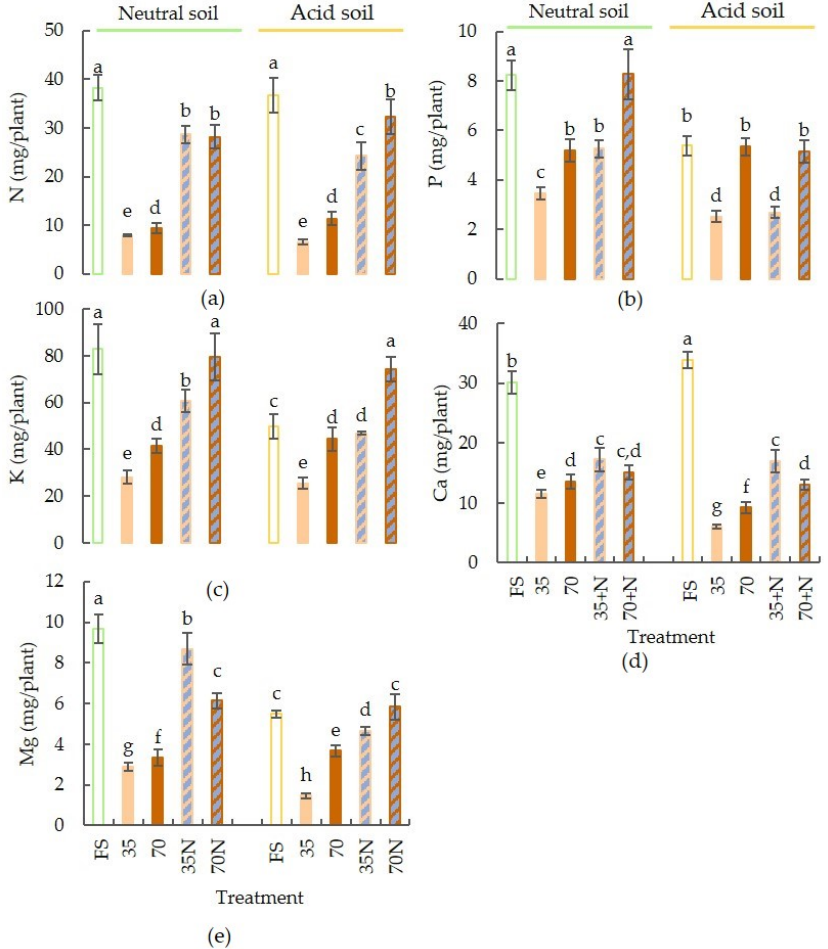
Figure 5. Effects of soil and MSWC supplemented or not with inorganic nitrogen on shoot N ( a ), P ( b ), K ( c ), Ca ( d ), and Mg ( e ) uptake rates. Note: FS—fertilized soil; 35—35 t MSWC ha-1; 70—70 t Means with different letters are significantly different at p < 0.05. Each bar represents the mean of six replicates, while the error bars represent ±